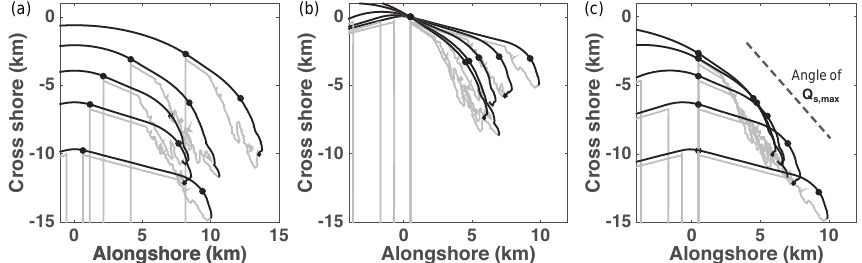
Figure 7. Different visualizations of symmetric spits growing off of different headland widths after 220 model years plotted (a) in “modeler’s view” symmetrically about the headland where x = 0 is location of the initial headland, (b) in “geologists view” with same location of spit origin after evolution (i.e., same Q s,in location in x direction), and (c) with the same right headland boundaries where x = 0 is the location of the initial headland. Also plotted is the trajectory of the angle at which alongshore sediment transport is maximized for the wave climate. Note that wave climate is the same for all simulations ( A = 0 . 5 , U = 0 .